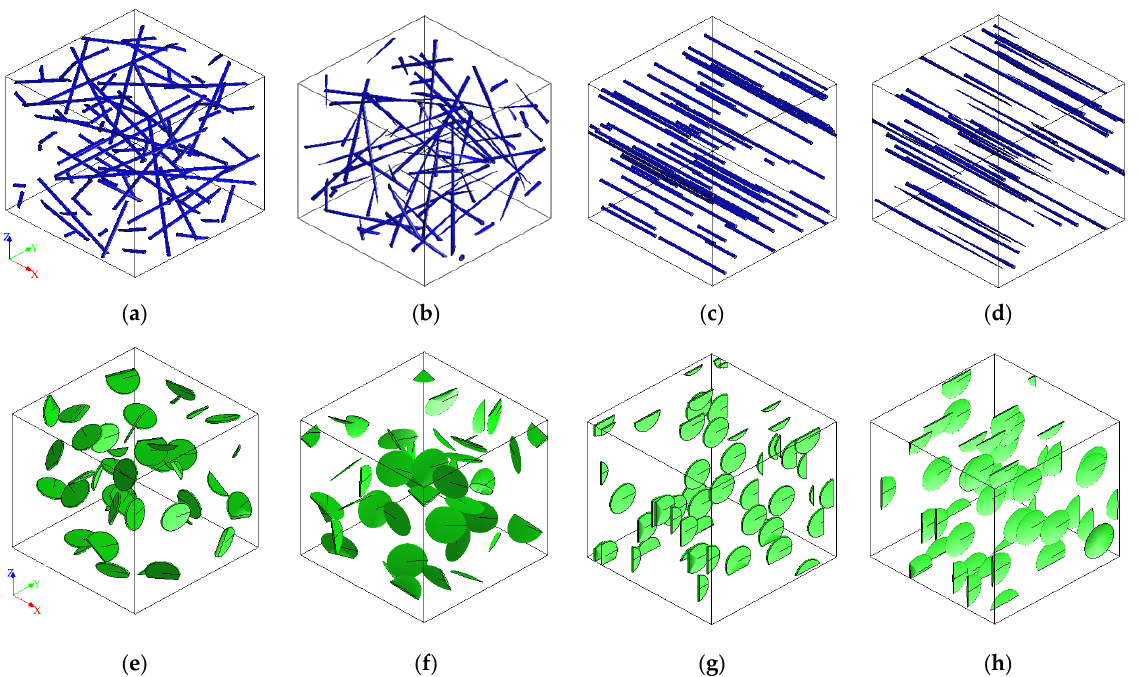
Figure 5. RVE of carbon nanotube (CNT) and graphene nanoplatelet (GNP) inclusions embedded in matrix polymer. ( a ) Random cylindrical. ( b ) Random prolate ellipsoid. ( c ) Aligned cylindrical. ( d ) Aligned prolate ellipsoid. ( e ) Random nanoplatelets. ( f ) Random oblate ellipsoid. ( g ) Aligned nanoplatelets. ( h ) Aligned oblate ellipsoid.